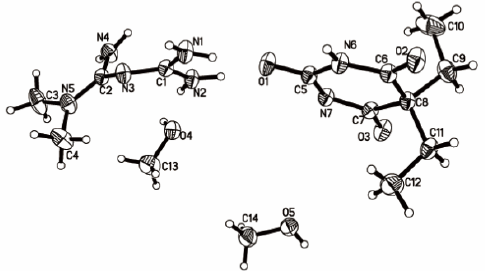
Figure 4. Thermal ellipsoid figure drawn at the 50% probability